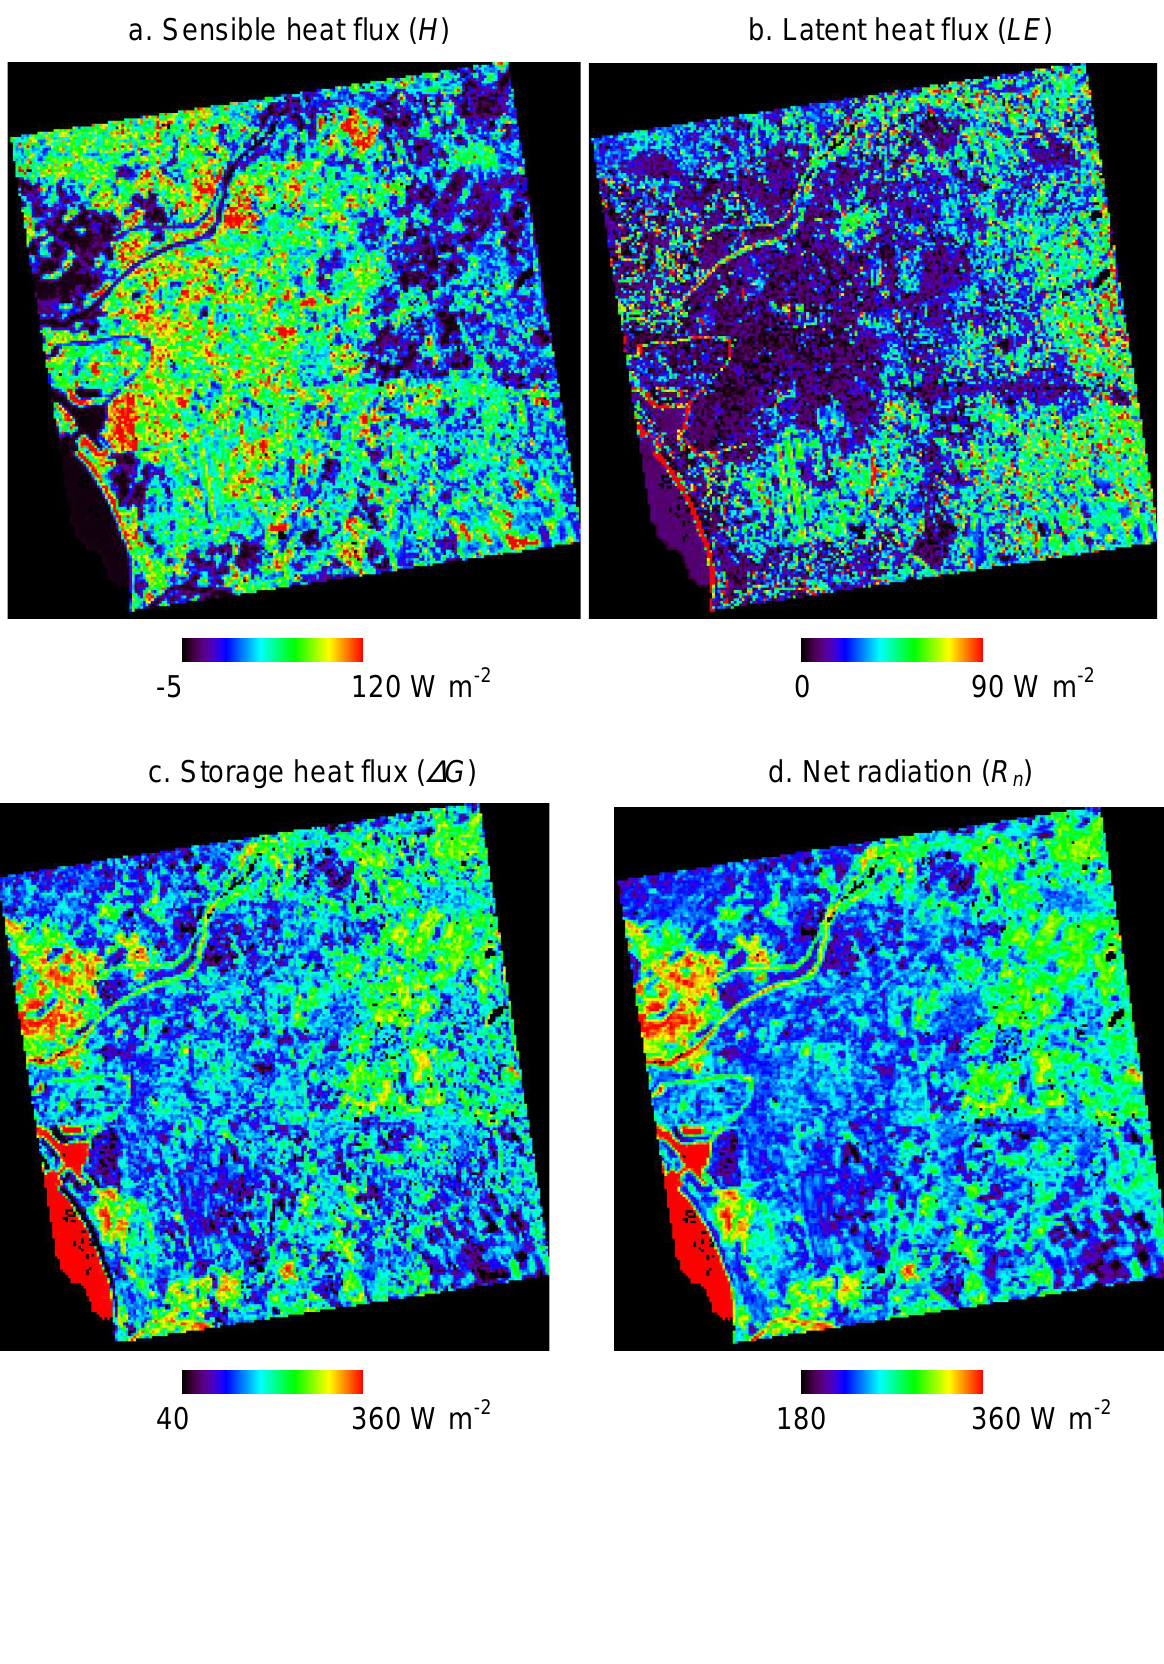
Figure 4. Distributions of (a) sensible heat flux H , (b) latent heat flux LE , (c) storage heat flux D G , and (d) net radiation R estimated by using a surface classification map from n ASTER